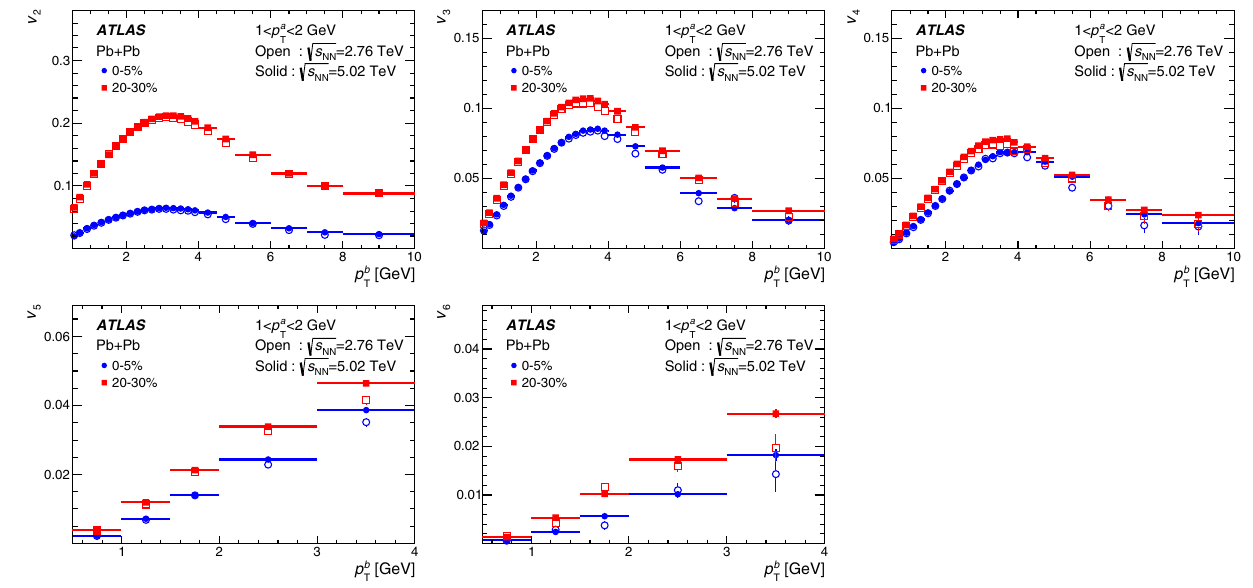
Fig. 9 Comparisons of the 2PC v n harmonics measured at √ s = 2.76 TeV (Run1) and at NN are plotted as a function of p b